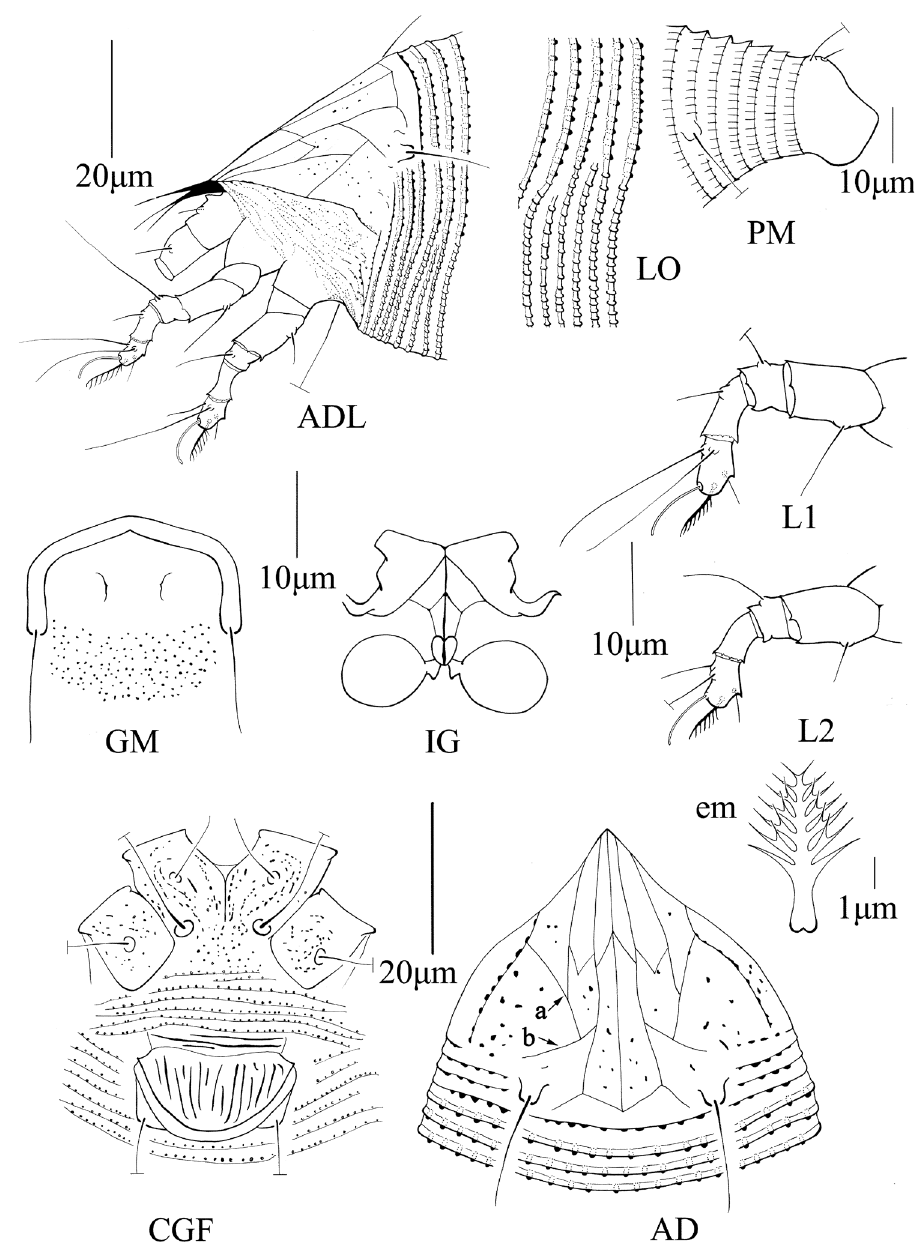
Figure 2. Schematic drawings of Aculops jilinensis sp. n.: ADL lateral view of anterior body region (slightly rotated dorsad) LO lateral view of annuli at mid-region of opisthosoma PM lateral view of pos- teriormost region of opisthosoma GM male genital region IG female internal genitalia L1 leg I L2 leg II em empodium CGF female coxigenital region AD prodorsal